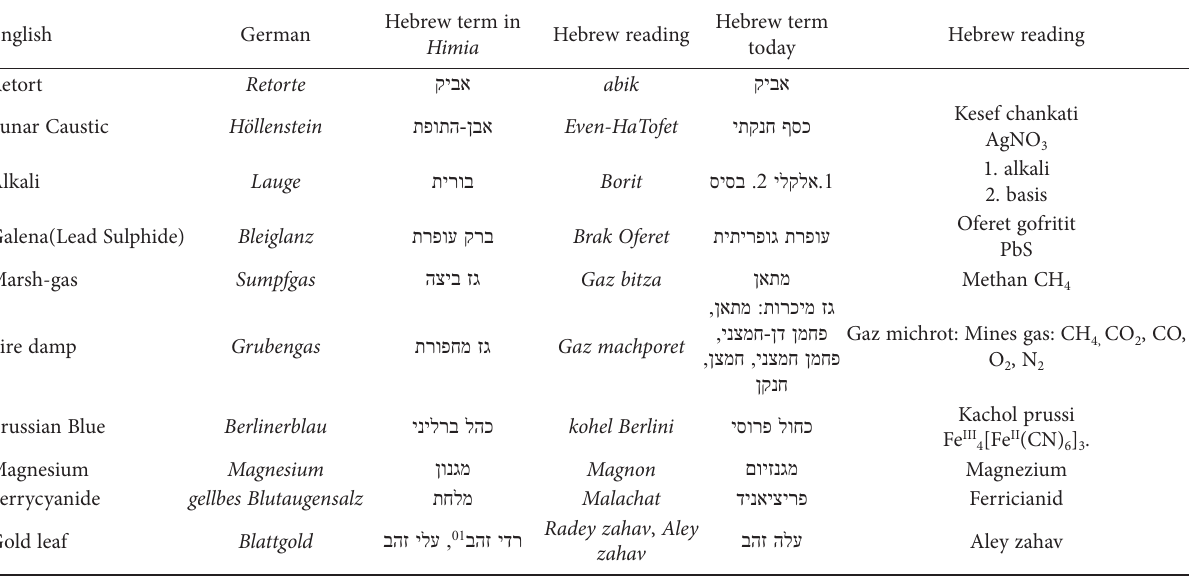
Table 1. Oirbach’s Himia terms translated from English and German 27 and recent Hebrew terms.